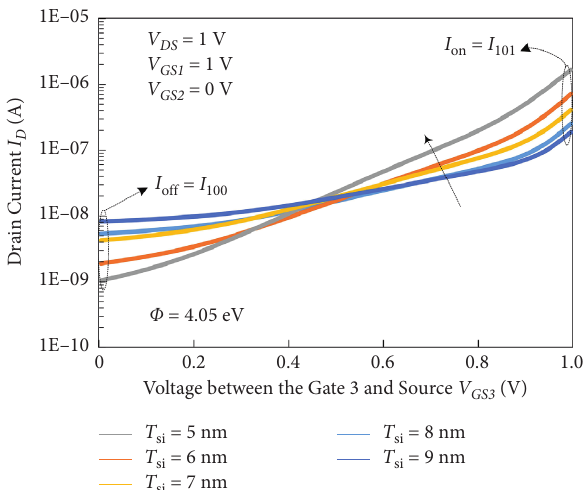
Figure 7: The I D - V GS3 characteristics of the Ti-TFETwith different body thicknesses ( T Si